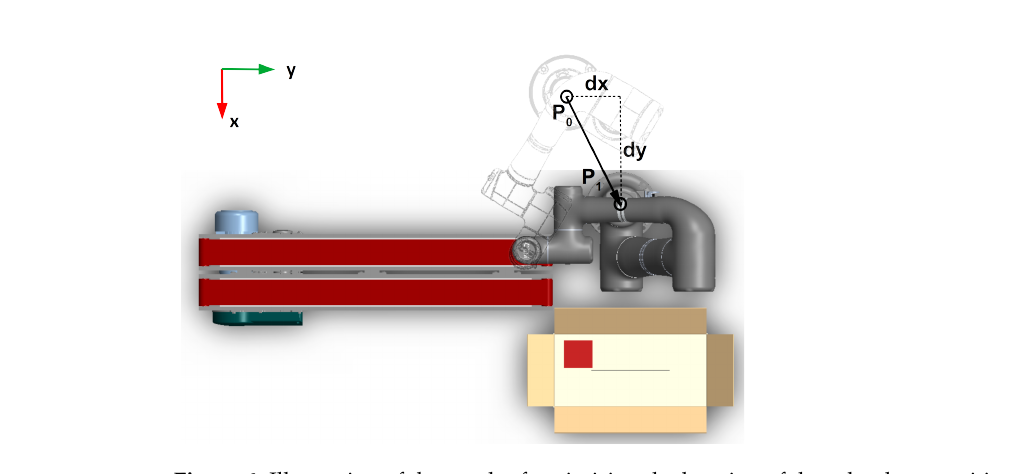
Figure 6. Illustration of the result of optimising the location of the robot base position relative to the task